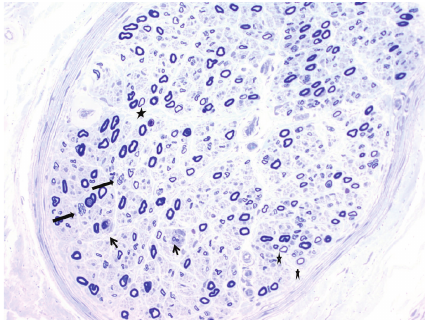
Figure 1: Semithin epoxy transverse section of sural nerve stained with toluidine blue. A transverse epoxy resin section shows mild axonal loss. Occasionally, clusters of small axons, suggesting axonal regeneration, are seen (long arrows). Thinly myelinated fibers are relatively often present (asterisks). There are a few macrophages in the section, engulfing the cell debris (short arrows) ( ×